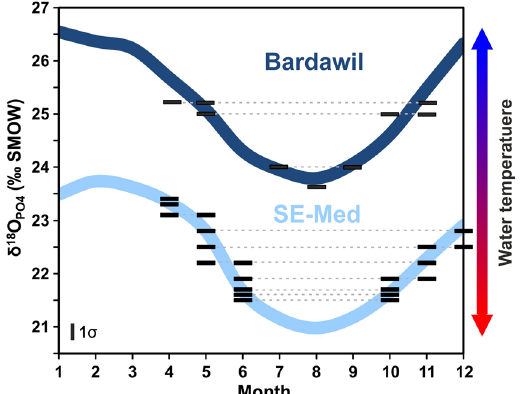
Figure 3. Blue sinusoidal curves represent the seasonal range expected for fish bioapatite δ 18 O PO4 values forming in isotope equilibrium with the water of the hypersaline Bardawil lagoon and southeast Mediterranean, respectively. For the Bardawil lagoon an average δ 18 O SW of 3.7‰ and a water temperature range of 14 to 28 °C 23,31,39 and for the southeast Mediterranean an average δ 18 O SW of 1.6‰ and a water temperature range of 15 to 30 °C 37,38 were used. Teeth of modern S . aurata fall within the predicted δ 18 O PO4 trend of their according habitat (data for Bardawil fish are from Kolodny et al . 23 ; data for southeast Mediterranean fish: Sisma-Ventura seems to have occurred year around. This reference frame was used to infer the habitat of ancient S . aurata